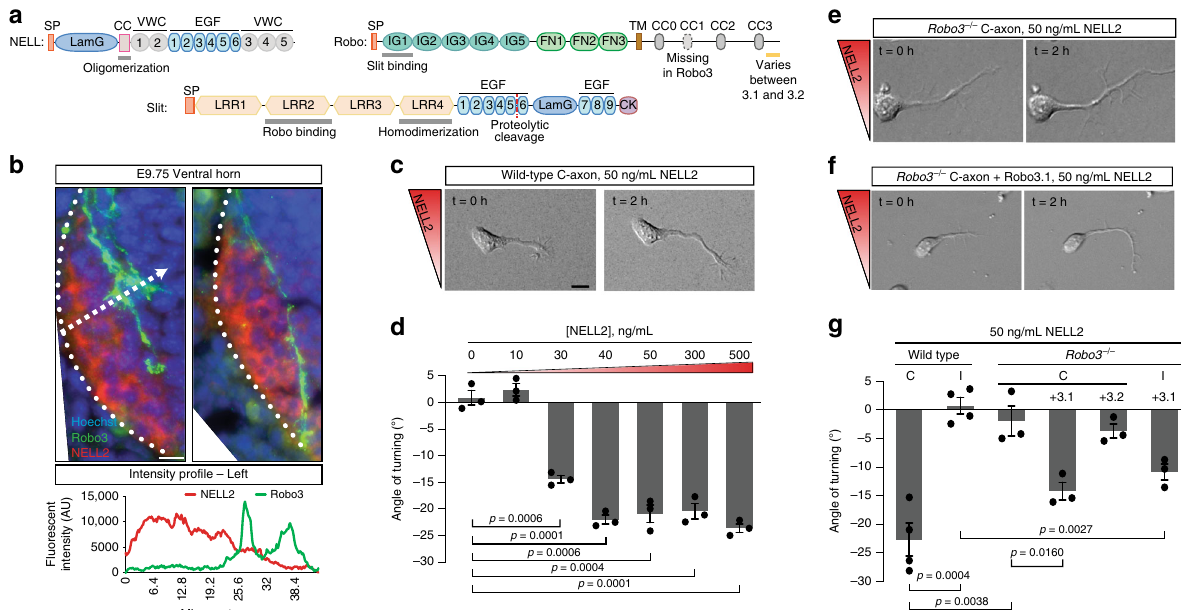
Fig. 1 Robo3.1 is necessary and suf fi cient for axon repulsion from NELL2. a Domain structure of NELLs, Robos, and Slits, drawn true to scale for human NELL2, Robo3, and Slit1. CC with numbers indicate conserved cytoplasmic motifs. SP signal peptide. TM transmembrane helix. CK C-terminal cysteine knot. b Transverse spinal cord sections from E9.75 mouse embryos were labeled with Hoechst stain and antibodies against Robo3 and NELL2. Robo3-expressing precrossing commissural axons grow around areas of NELL2 expression in the ventral horn. Dotted line indicates spinal cord border. Fluorescence intensity pro fi le (bottom) was generated by line scan along the dashed arrow. c DIC images of a commissural axon turning away from a gradient of NELL2 in a Dunn chamber (0 and 2 h). d Quanti fi cation of commissural axon turning angles for increasing concentrations of NELL2 ( n = 3 independent experiments for all conditions). e , f DIC images of Robo3 − / − neurons in a NELL2 gradient. Robo3 − / − axons do not turn in response to NELL2 ( e ), unless rescued with Robo3.1 ( f ). g Quanti fi cation of turning angles in response to NELL2 for commissural (labeled C) axons (wild type or Robo3 − / − with or without Robo3.1 or Robo3.2 rescue) or ipsilateral (labeled I) axons ( n = 4 for wild-type commissural and ipsilateral axons, n = 3 for all other conditions). Scale bar, 10 μ m ( b , c , e , f ). Error bars indicate